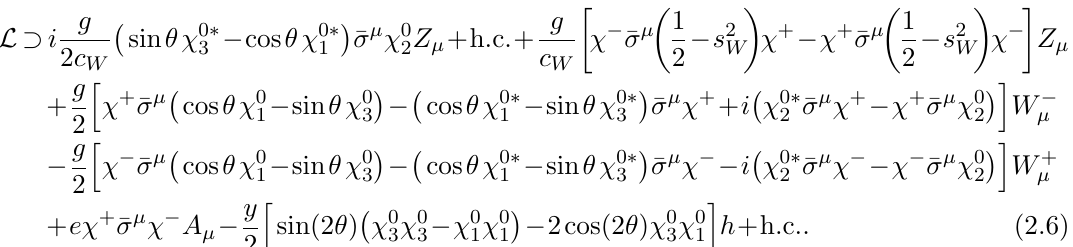
couplings are given